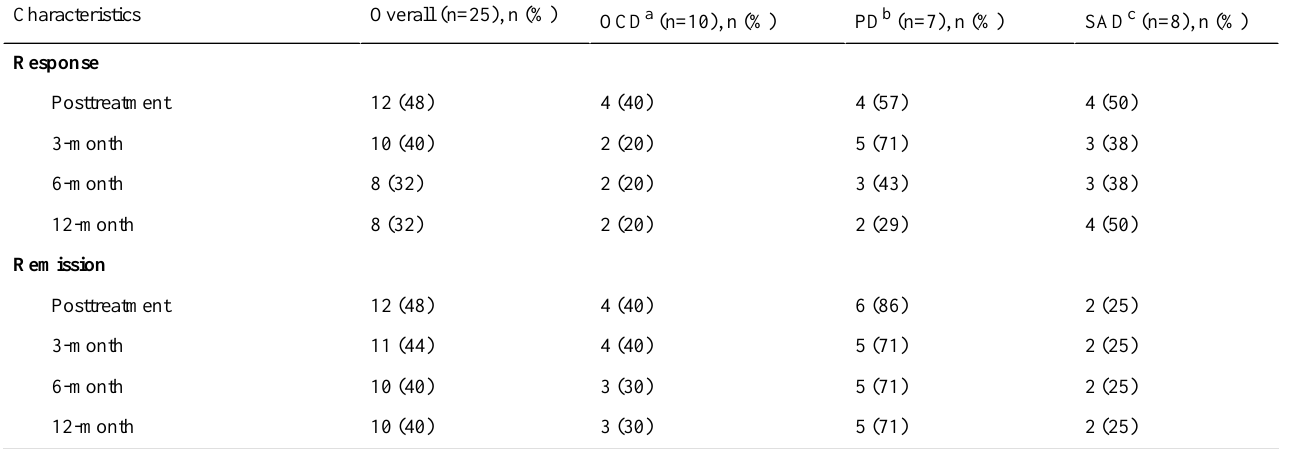
Table 3. Participant response and remission rates at each follow-up end point.